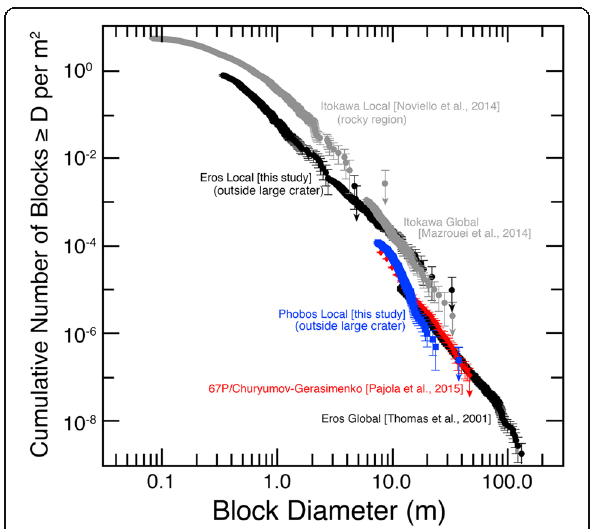
Fig. 5 Figure taken from Rodgers et al. (2016) showing the size frequency distribution of the blocks measured on Eros, Itokawa, Phobos, and comet 67P/Churyumov-Gerasimenko (see Rodgers et al. 2016, Fig.